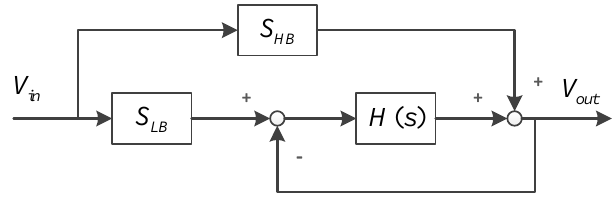
Figure 4. Block diagram of multi-sensor frequency-domain fusion method.